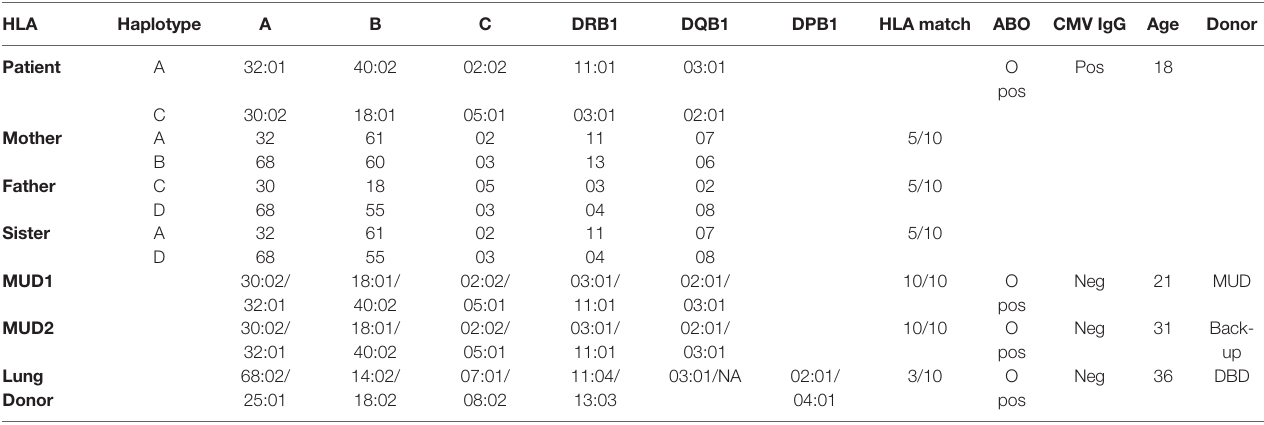
TABLE 1 | HLA pro fi le of index case, relatives and